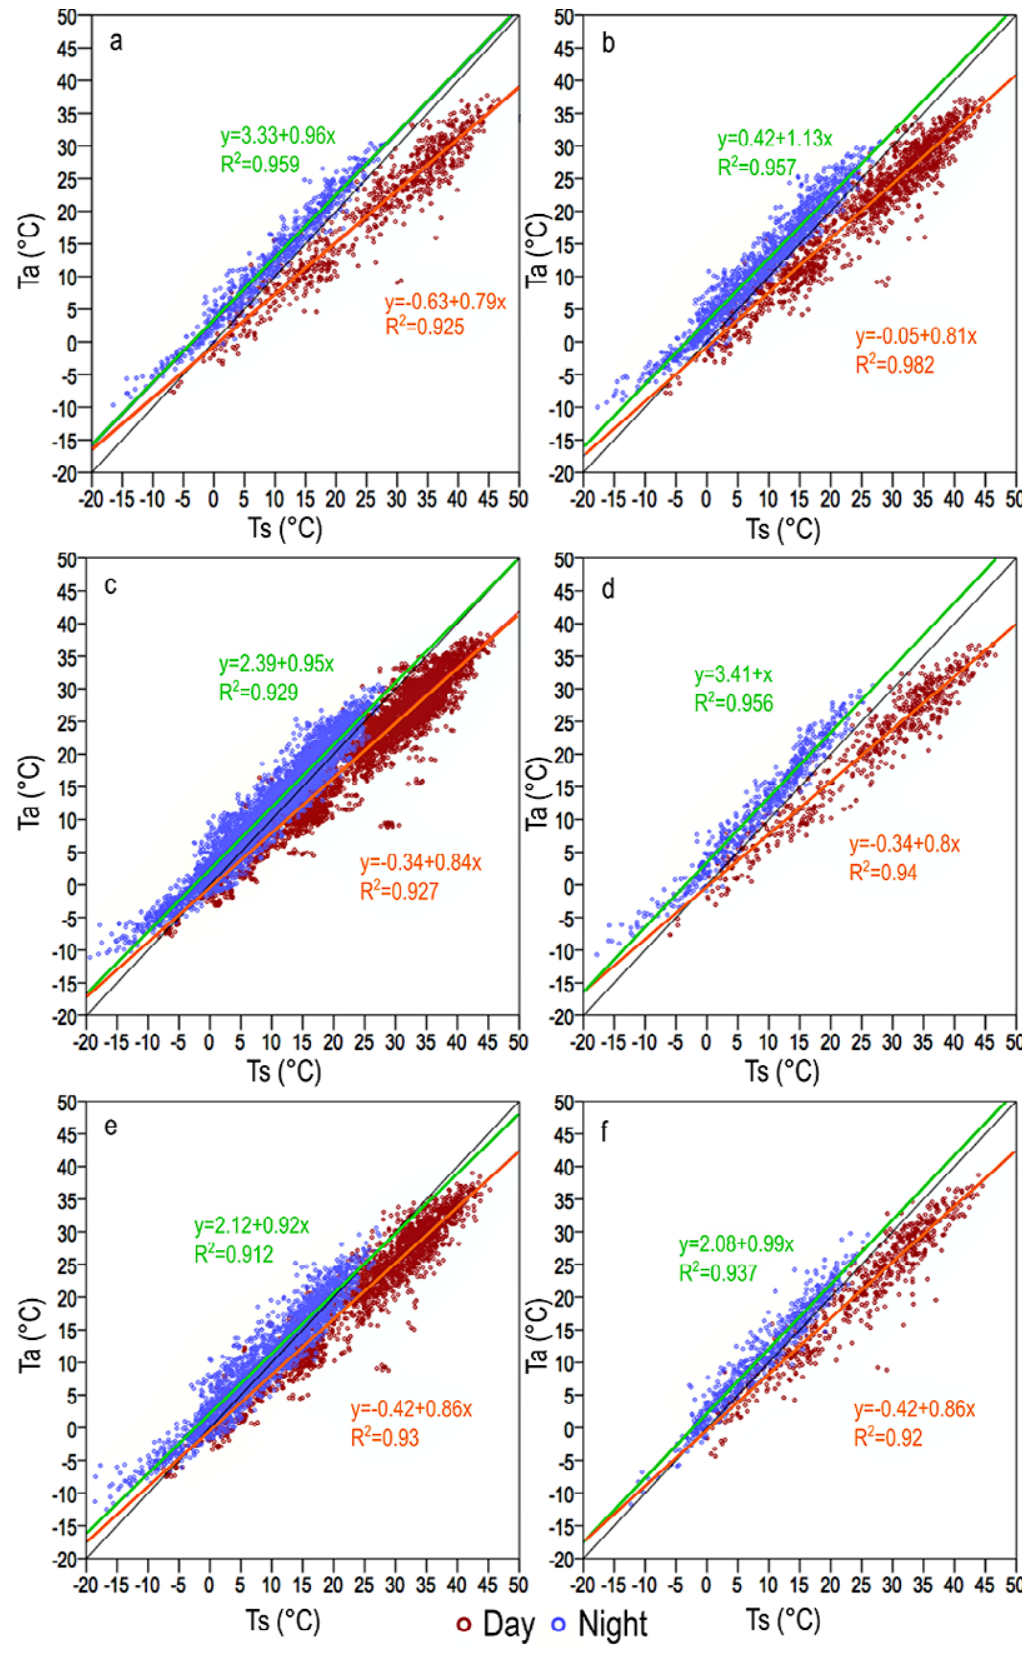
Figure 6. Linear regression relationship (orange lines: day, green lines: night) fitted between surface (T and air (T ) temperatures by LCZs (a – LCZ 2, b – LCZ 5, c – LCZ 6, d – LCZ 8, e – LCZ 9, f – LCZ D) a (Szeged, clear days, 01.06.2014 –